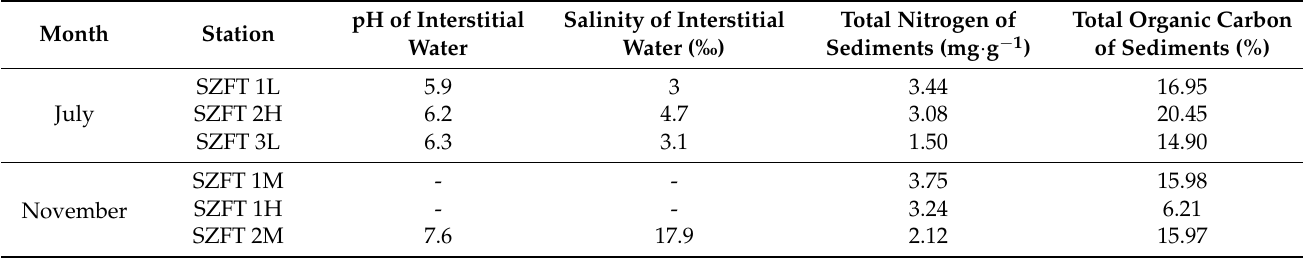
Table 1. Characteristics of surface sediments from sampling stations.